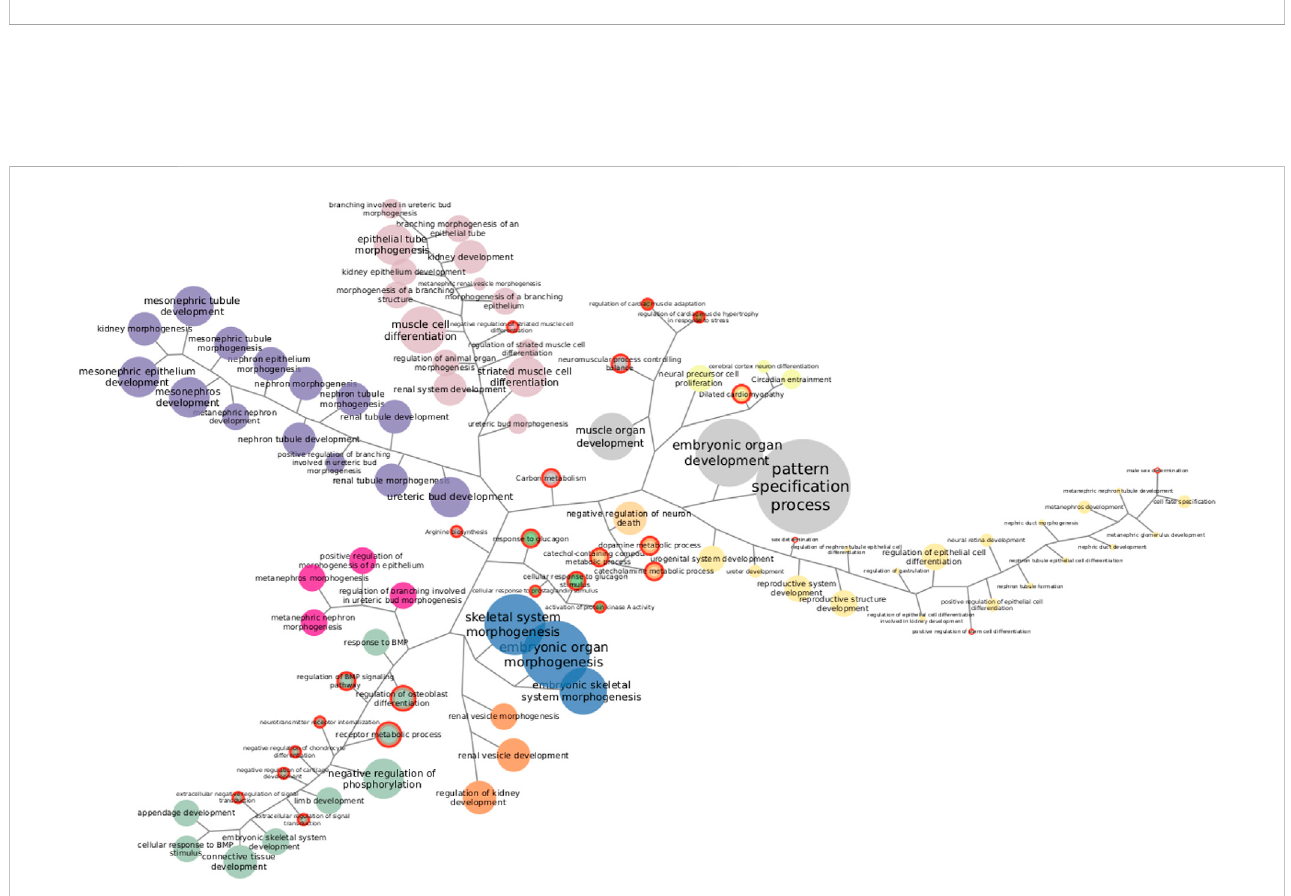
FIGURE 3 Enriched functions. (A) Feature similarity between functions shared by the pair of datasets indicated. Functions with similarity over 0.5 are displayed. (B) Bias of exclusive functions. An asterisk marks categories with signi fi cant over-representation (Fisher ’ s test, Bonferroni adjusted p -value < 0.05).